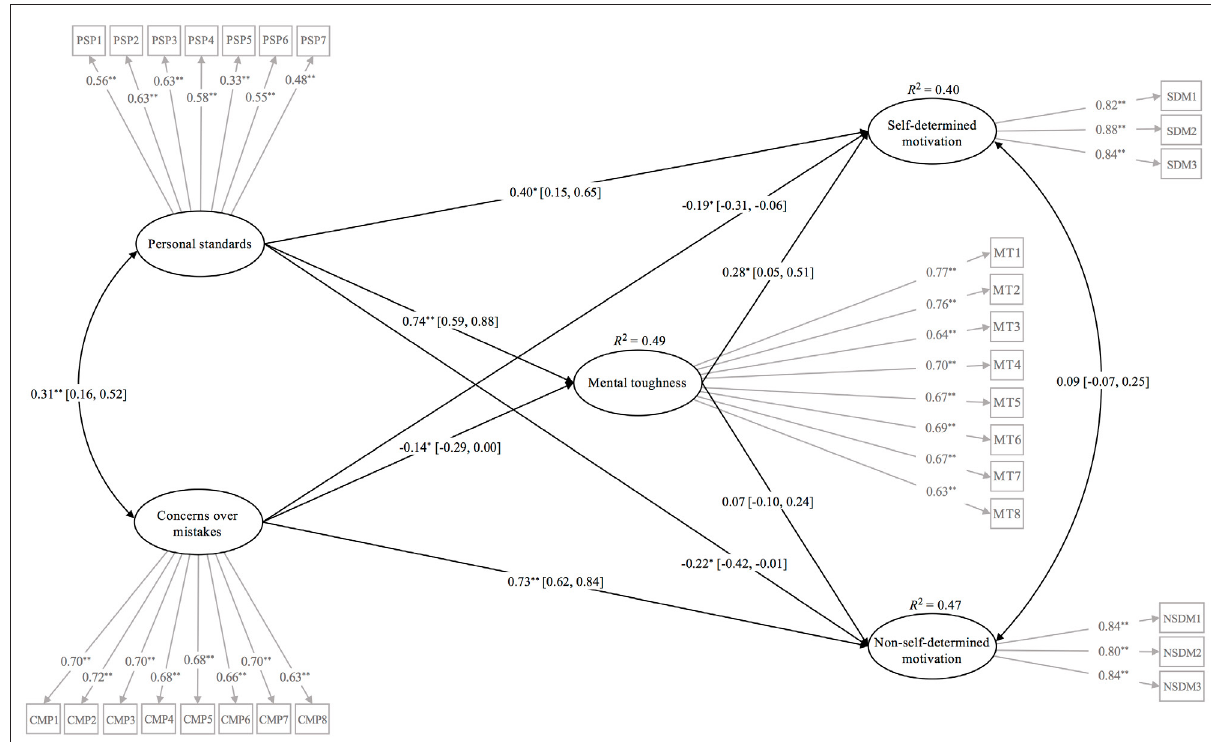
Figure 2: Final partial mediation model for relations between dimensions of perfectionism, mental toughness and self-determined motivation (standardised coefficients and 95% confidence intervals